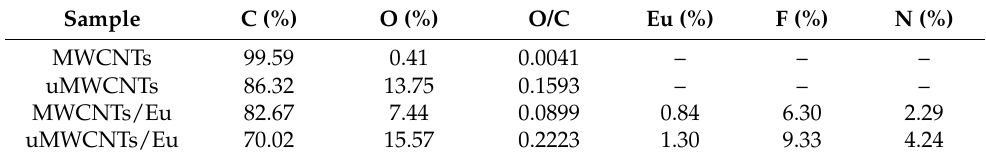
Table 1. XPS analysis results of MWCNTs/Eu, uMWCNTs/Eu, MWCNTs/Eu and uMWCNTs/Eu.